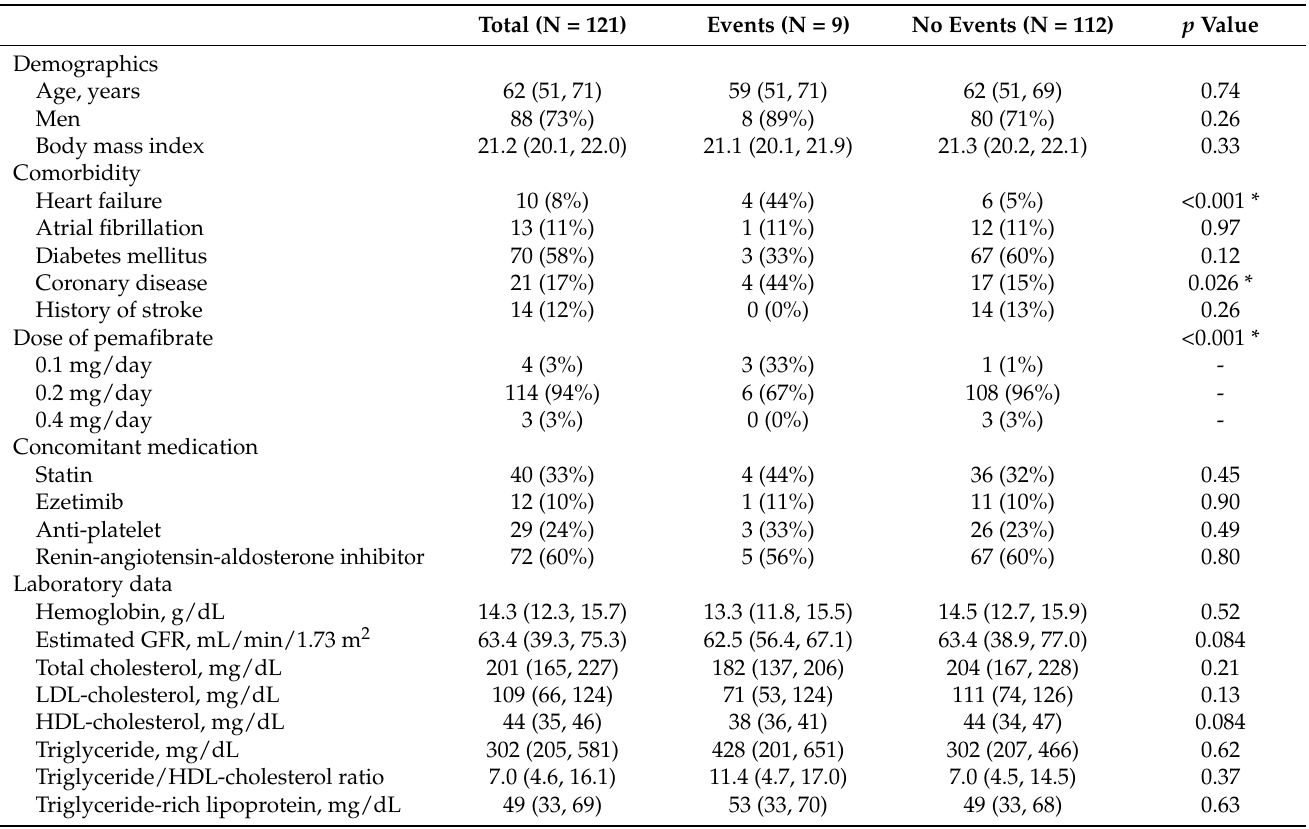
Table 1. The baseline